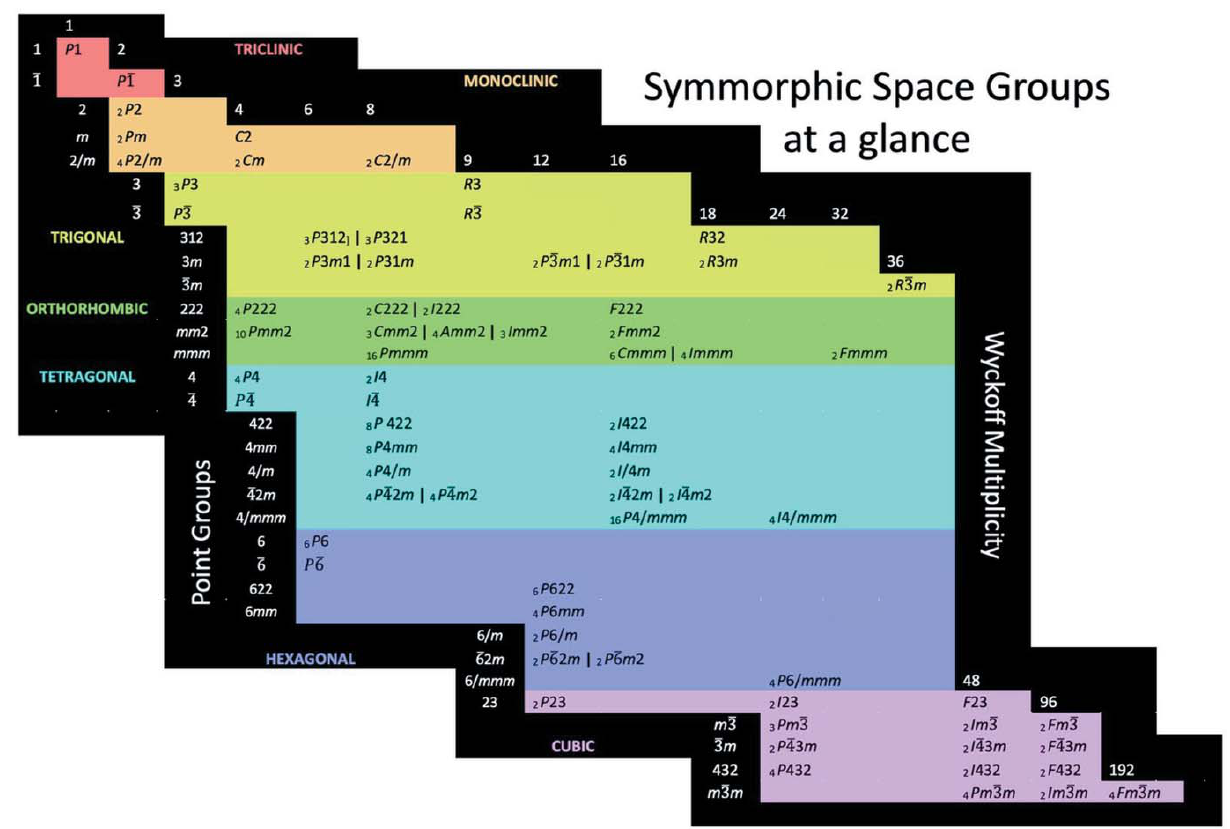
Figure 2 If the International Table for Crystallography, Volume A (Hahn, 2006) were reduced to one page it might resemble a periodic-like table of space groups. Point-group symmetry and Wyckoff multiplicity are plotted along non-orthogonal axes, separating the crystal systems into colored